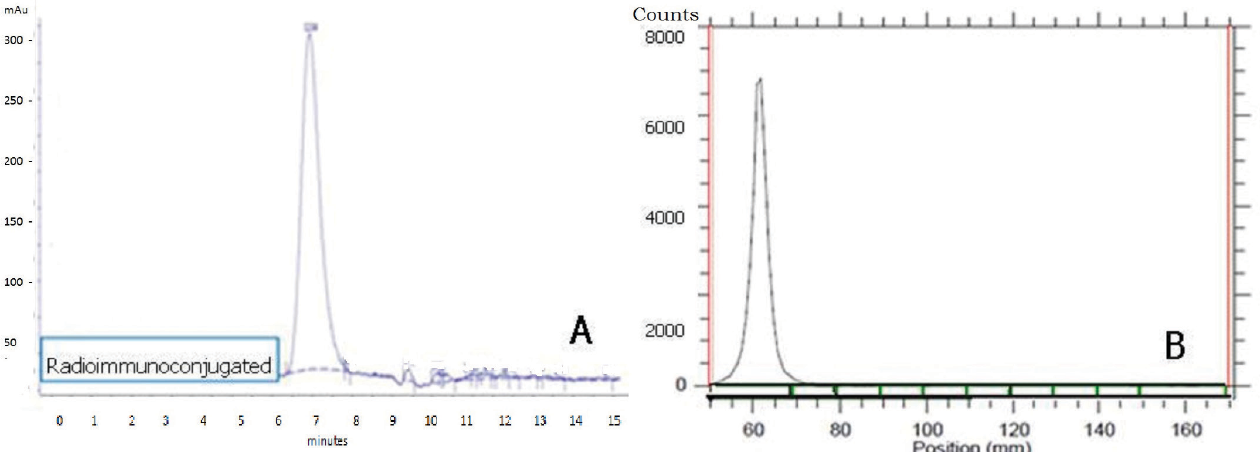
FIGURE 7 - HPLC chromatographic profile of the radioimmunoconjugate, 185MBq/mg (A). TLC scanner chromatographic profile of the radioimmunoconjugate, 185MBq/mg